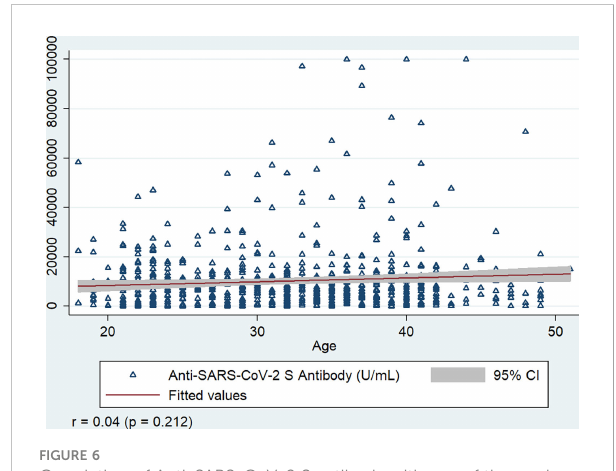
FIGURE 6 Correlation of Anti-SARS-CoV-2 S antibody with age of the workers, Bangladesh, 2021-22. r = Spearman ’ s rho, P value is generated by Spearman ’ s rank